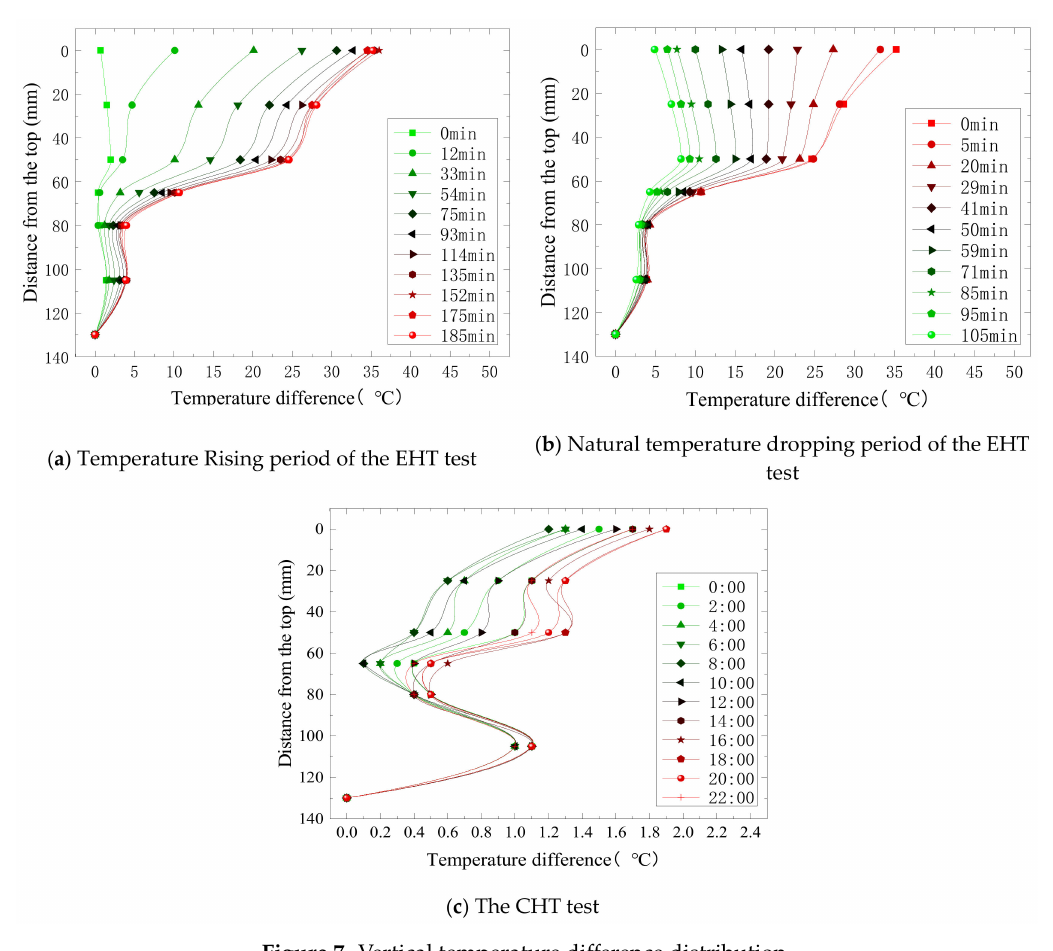
Figure 7. Vertical temperature di ff erence distribution.